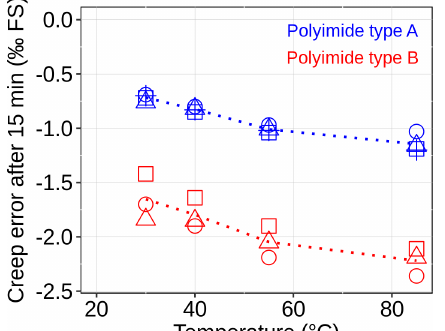
Figure 5. Material creep error after 15min of an aluminum bending beam measured by means of a capacitive displacement sensor.